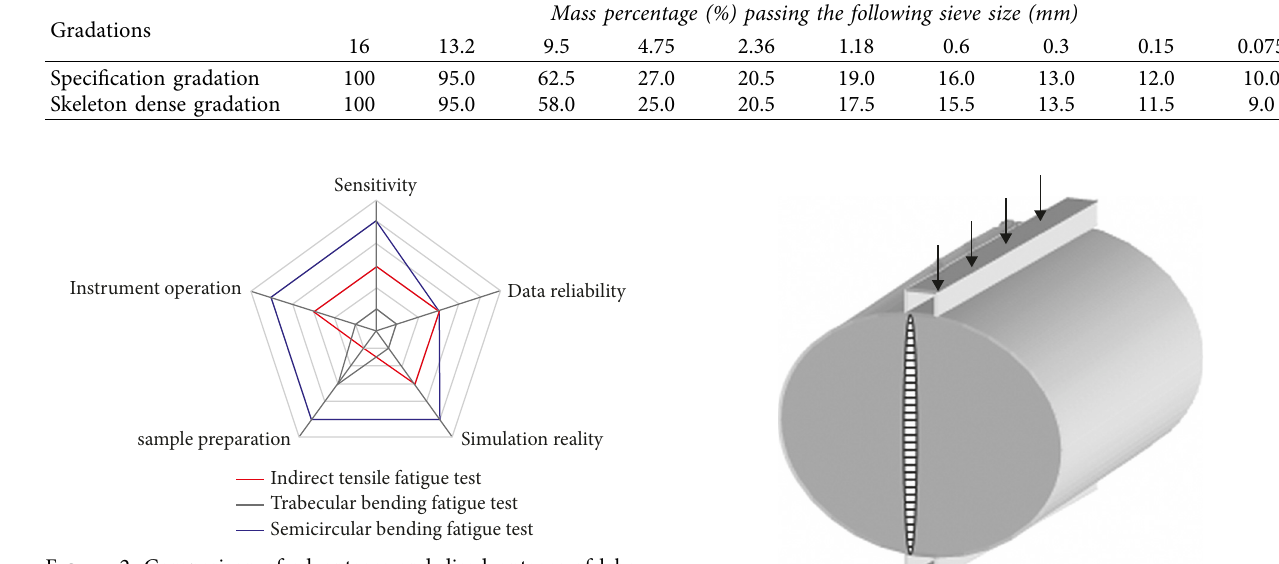
Table 3: Aggregate gradations of the SMA-13 mixtures.